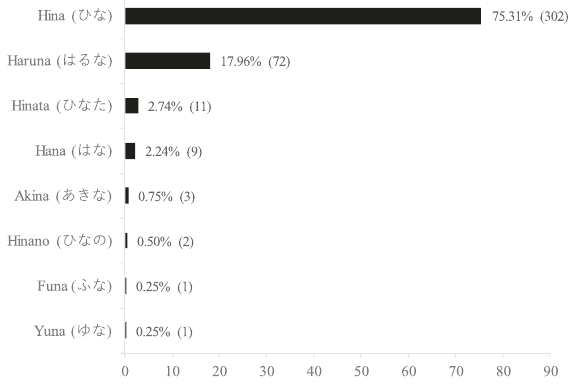
Fig. 6 Variations in readings of the name 陽 菜 . Scores indicate relative frequencies of each reading among the sample ( n = 401). Scores in parentheses indicate the absolute frequencies of each reading.